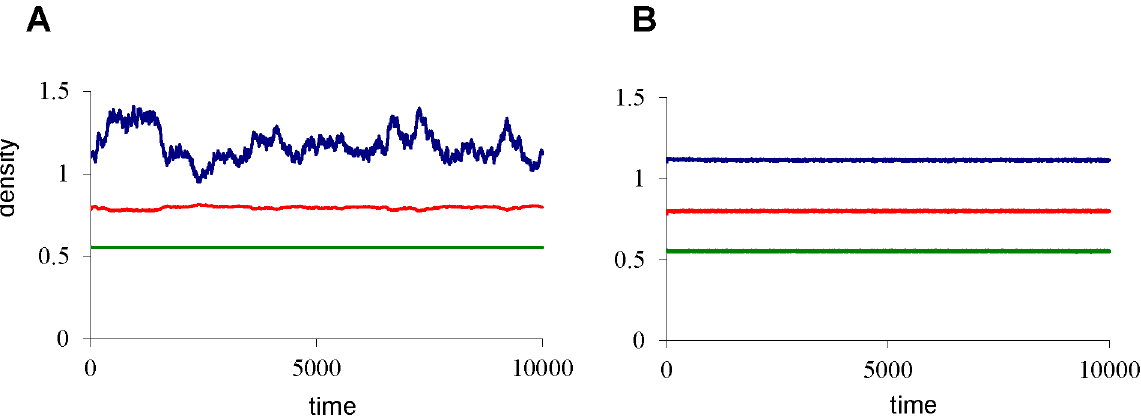
Figure 5. Early warning signals in the linearized system. The model of Figure 1 is linearized using the Jacobian matrix. Predator death rate is set at m P =0.5528 (very close to the bifurcation point T1 in Figure 1). The death rate of either the juveniles or the adults is perturbed using white noise with standard deviation s =0.005. ( A ) When noise is added to the juvenile death rate, the juvenile population (indicated in blue) clearly shows critically slowing down, whereas the adult (green line) and predator (red line) populations do not show early warning signs. ( B ) When noise is added to the adult death rate, all three populations do not show any sign of early warning. Note that the fluctuations in the juvenile population in Figure 5A are so large, that the full (i.c. not linearized) system would shift to the alternative steady state. doi:10.1371/journal.pone.0062033.g005 and fully correlated noise (Figure 3D) all autocorrelations are decreasing towards the catastrophe. In case of noise on juveniles (Figure 3A) or independent noise to all variables (Figure 3C), a clear early warning signal again only occurs in the juvenile population.